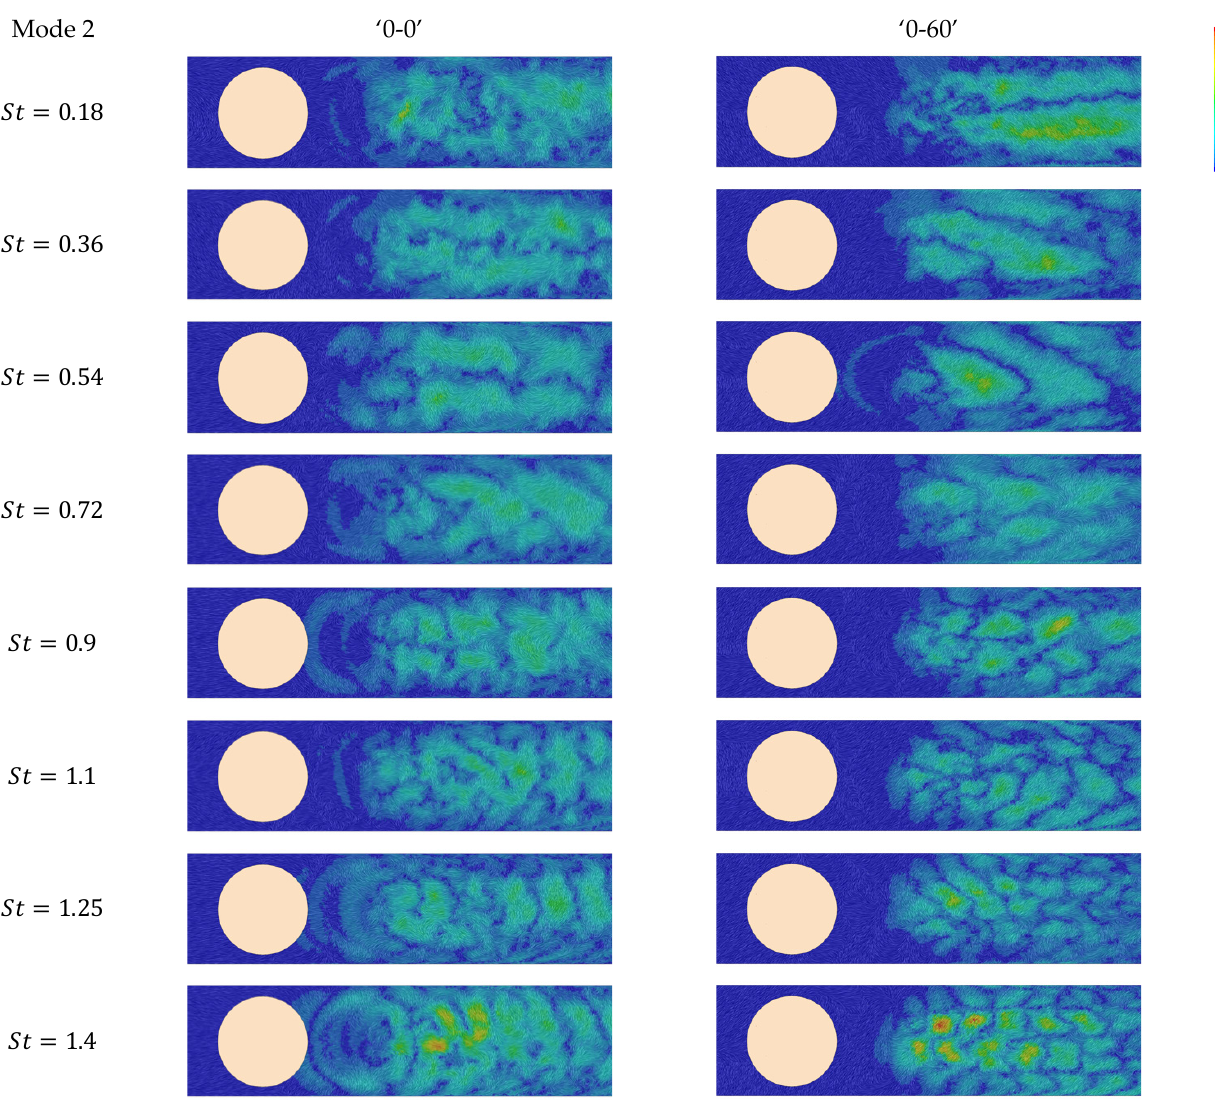
Figure 26. Contour plots of mode 2 of in-plane velocity vector coloured by mode magnitude for XY plane.